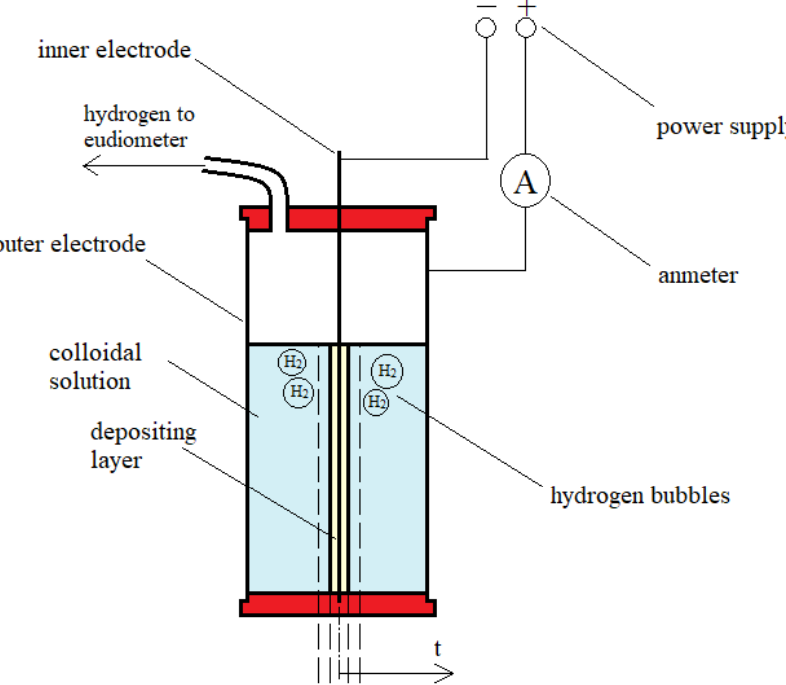
Figure 7. Schematic picture of reactor for tubular-shaped layer electrodeposition.